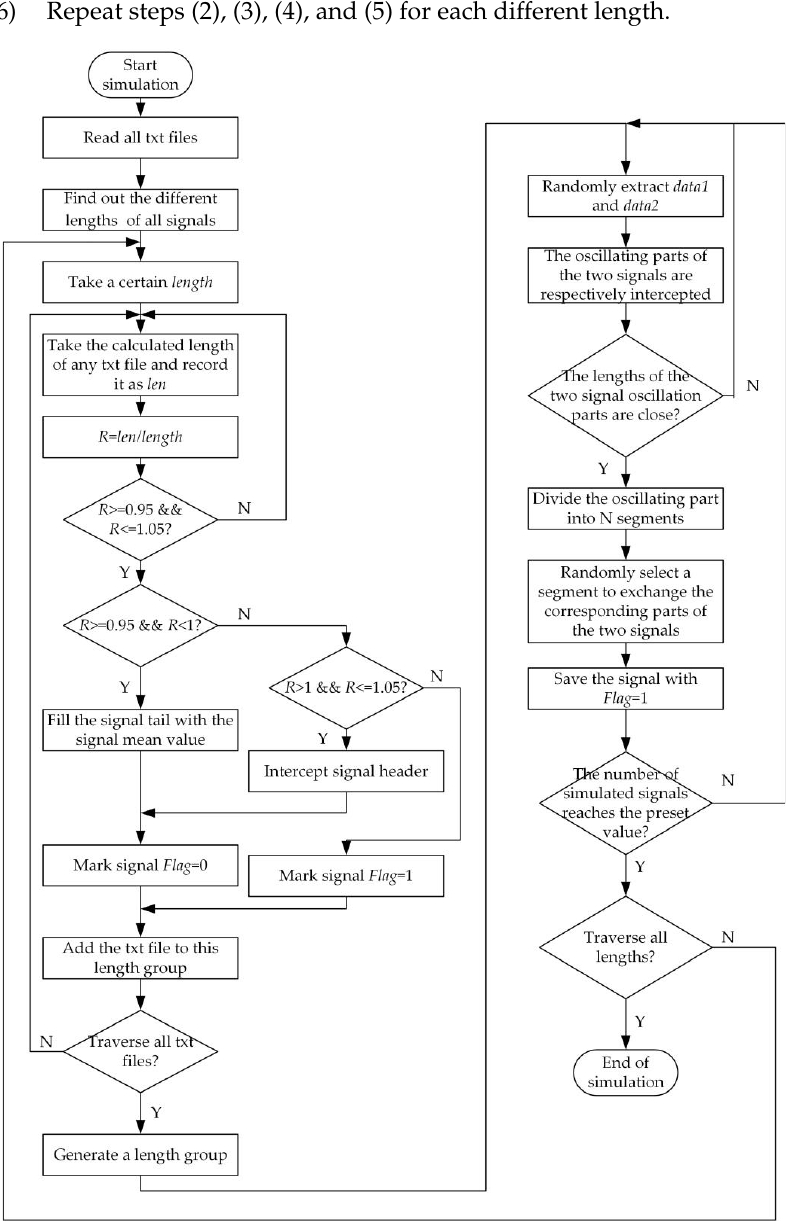
Figure 9. Simulation algorithm. The difference between the simulated signal and the measured signal can be quan- tified by the Euclidean distance after wavelet packet decomposition. After analyzing the simulated signals, the distance filtering threshold of the simulated signals is set as 20. With the time domain waveform manually screening and Euclidean distance filtering, a total of 832 simulated broken wire signals and 832 simulated non-broken wire signals are obtained. The comparison between the two types of simulated signals and the measured signals is shown in Figures 10 and 11. Note that the simulated signals are rather close to the measured signals. To better utilize the limited number of measured signals, it will be used as the test set of the coming machine learning models. The simulated signals are mainly for the model training purpose.